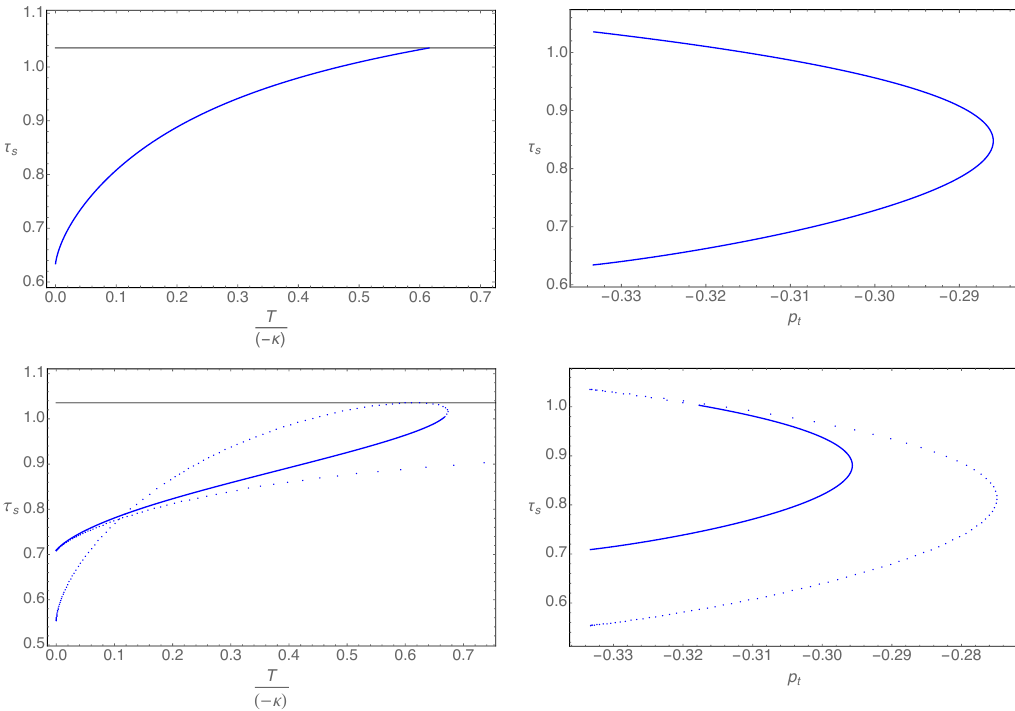
Figure 8 . The proper time τ s as a function of T/ ( − κ ) ( left ) and p t ( right ) for the model in subsection 3.1 ( top plots ) and in subsection 3.2 ( down plots ). For these plots, the grey line is for Schwartzschild black hole, the solid blue line is for stable hairy black hole solution while the dotted blue lines are for unstable hairy black hole